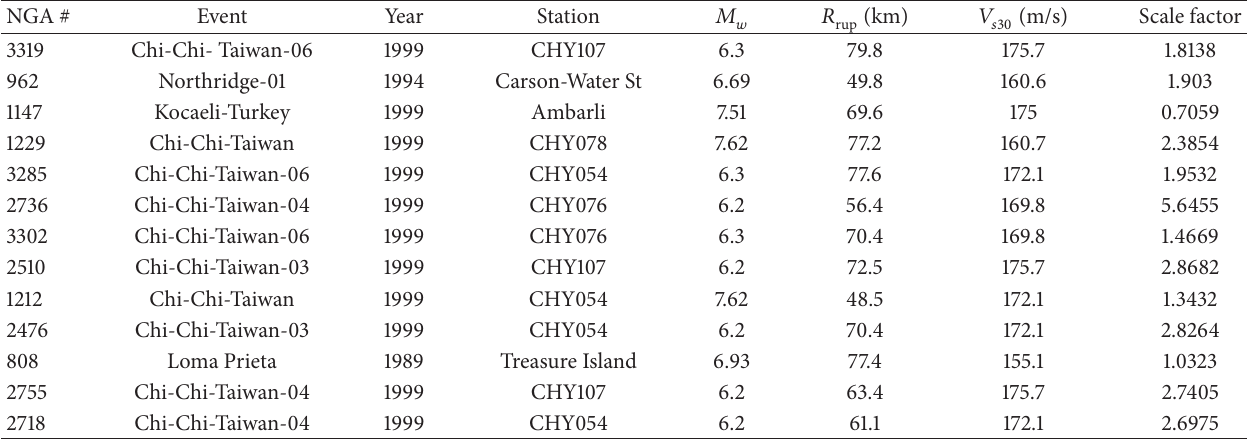
Table 5: Selected ground motion records for site class